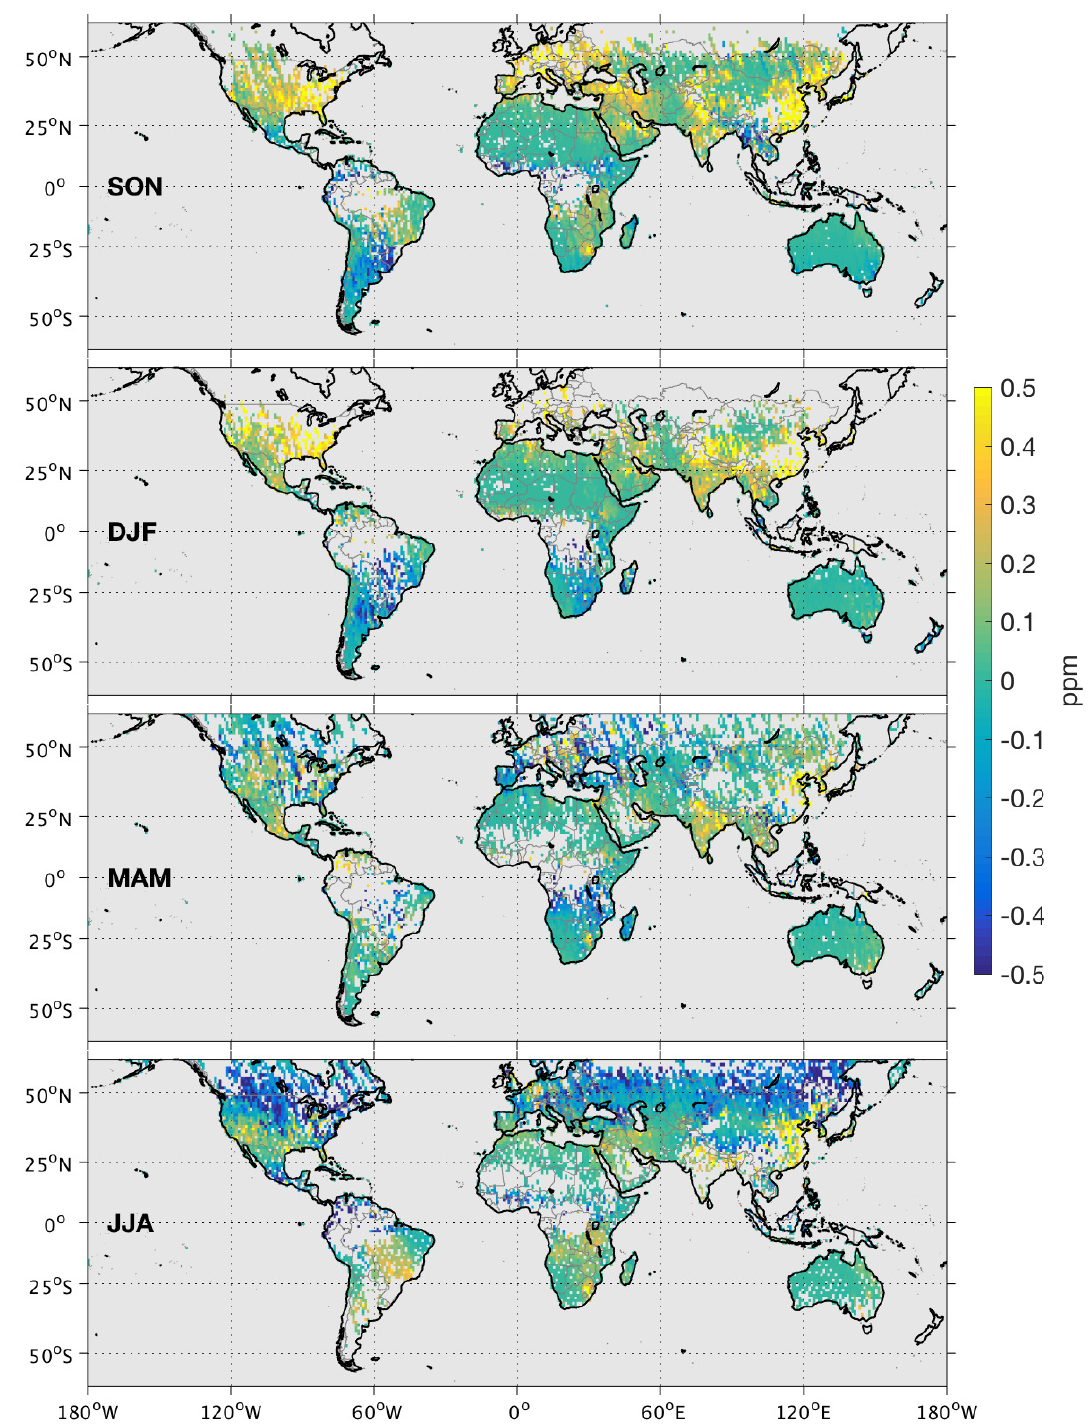
Figure 8. FLEXPART seasonal XCO 2 enhancement simulations from September 2014 to August 2015, including fossil fuel and biospheric contribution (FF +